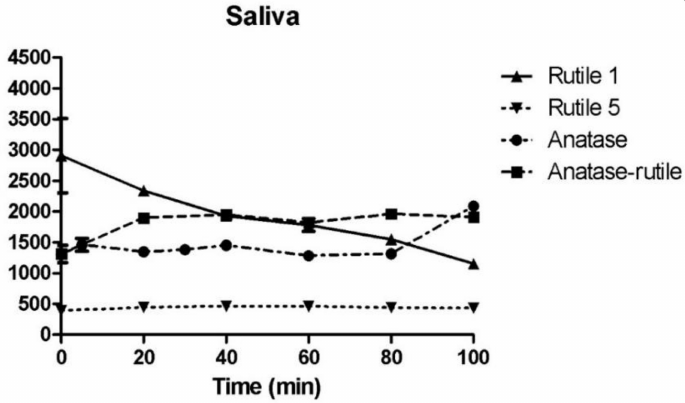
Figure 4. Time-dependent change in particle size of TiO 2 particles in simulated saliva. The starting concentration of the TiO 2 particles was 0.5 mg/mL dispersion